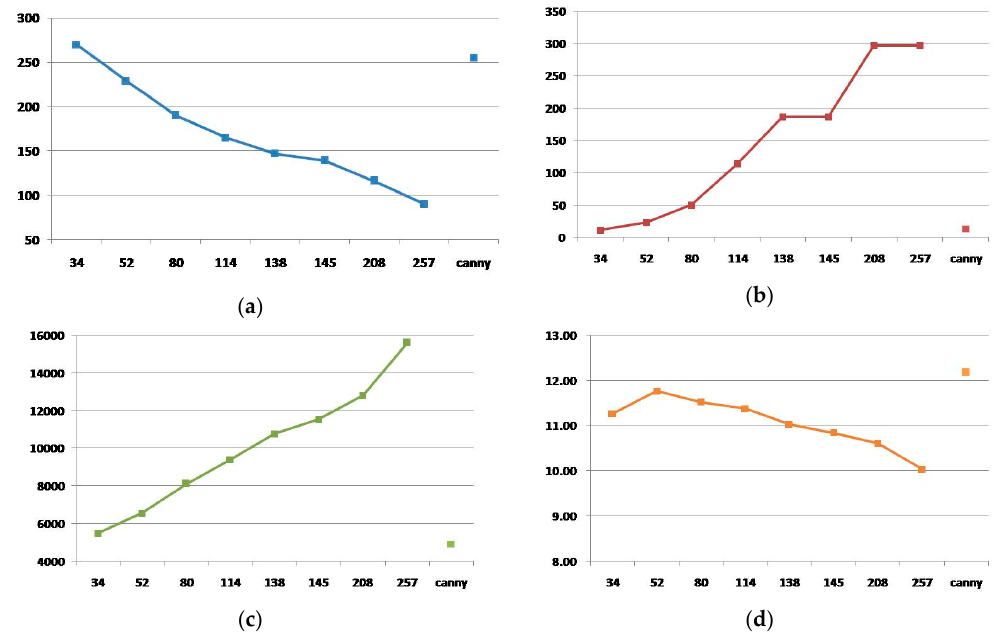
Figure 6. Statistical summary of a few yardang morphological parameters in the study area using the two methods: ( a ) the total number, ( b ) minimum area (m 2 ), ( c ) mean area (m 2 ), and ( d ) median direction (°).